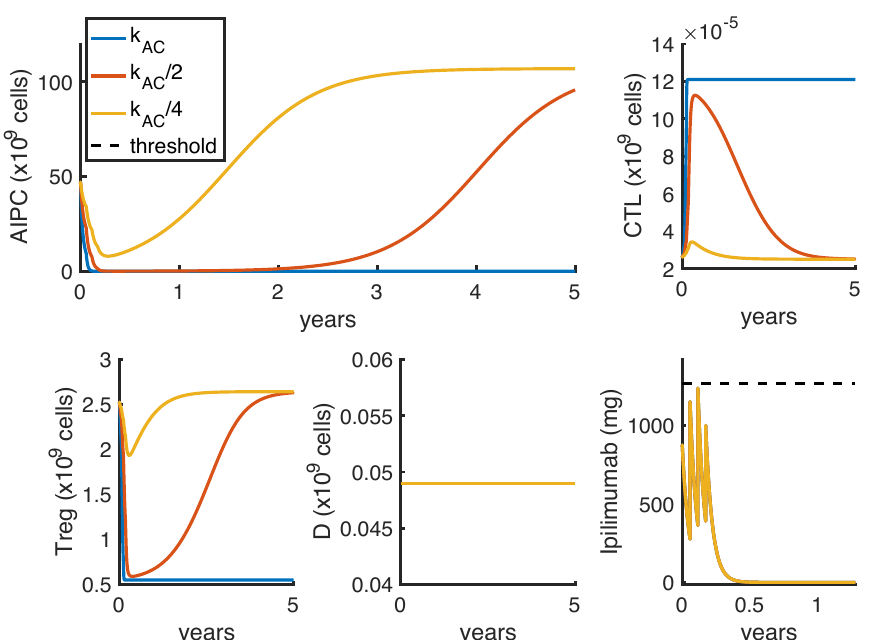
Figure 7. Graphical sensitivy analysis on the parameter k AC , representing the maximal killing rate